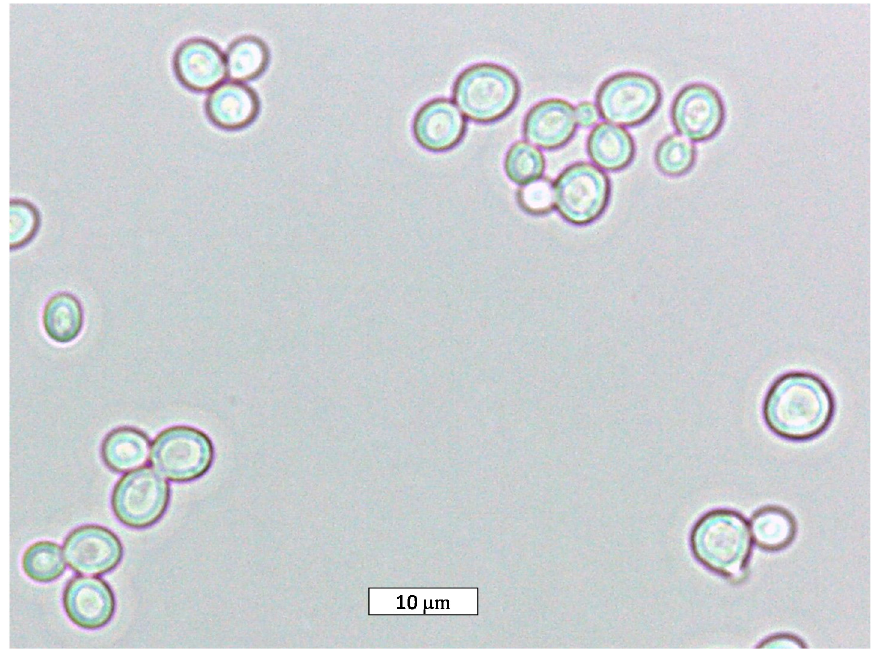
Figure 1. Optical microscopic picture of the species Z. rouxii (100× magnification).